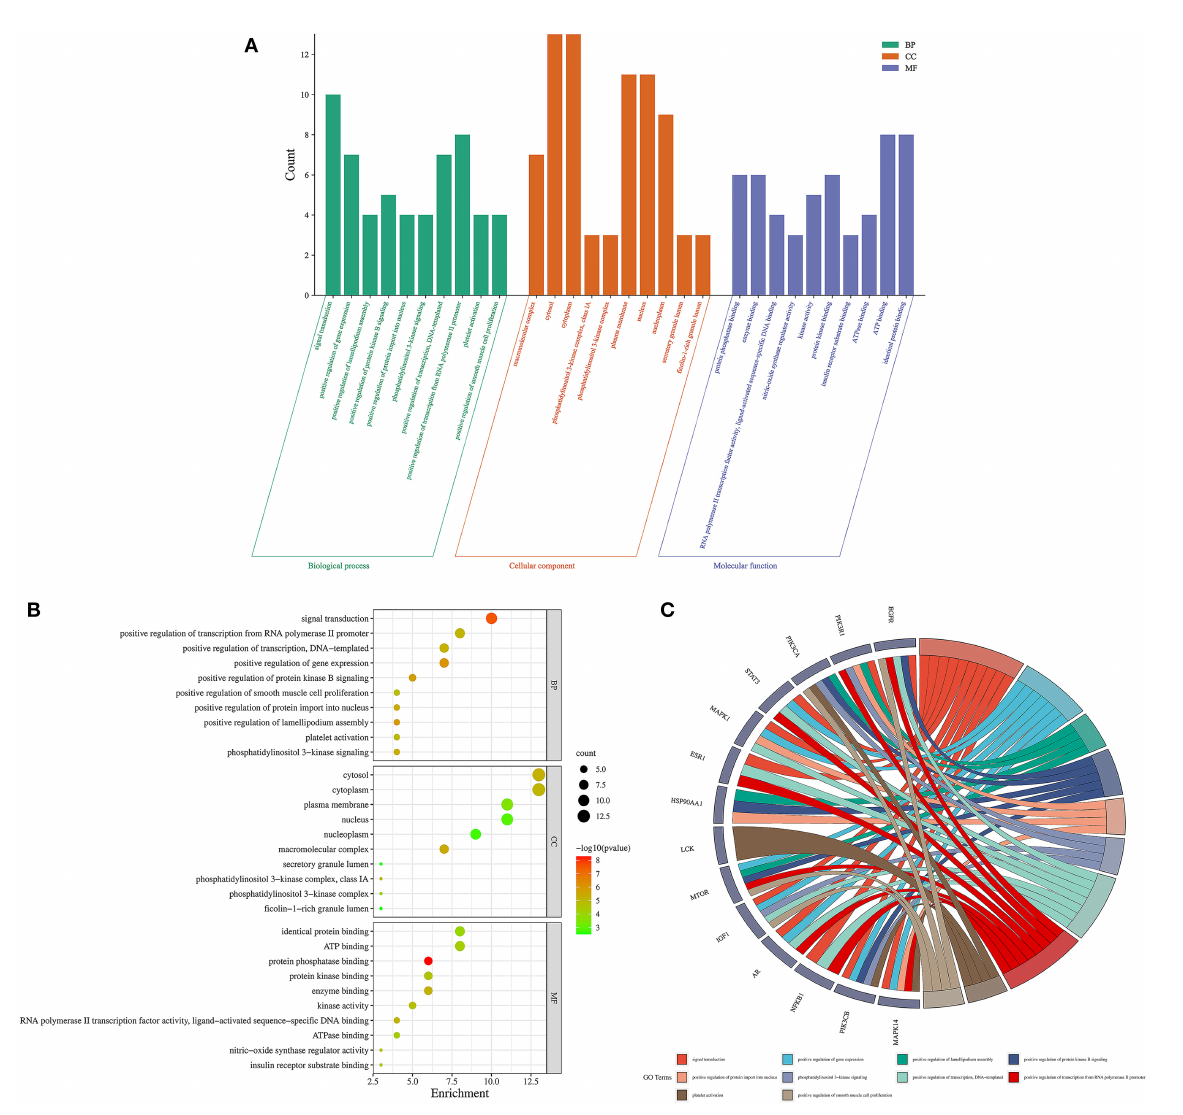
FIGURE5 Gene ontology enrichment analysis findings in 1,25-dihydroxyvitamin D against COVID-19/DM. Bar charts of biological processes, cellular components, and molecular functions (A) , bubble chart of biological processes, cellular components, and molecular functions (B) , circle chart of hub targets and biological processes (C)